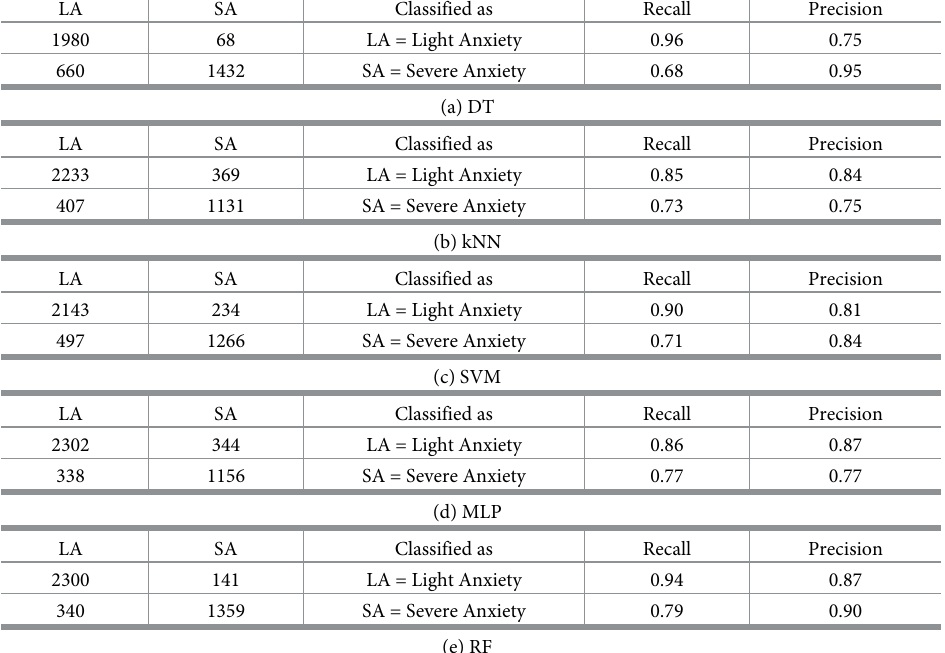
Table 2. Confusion matrix for two level anxiety classification for DT, kNN, SVM, MLP and RF classifier using SAM based labeling.